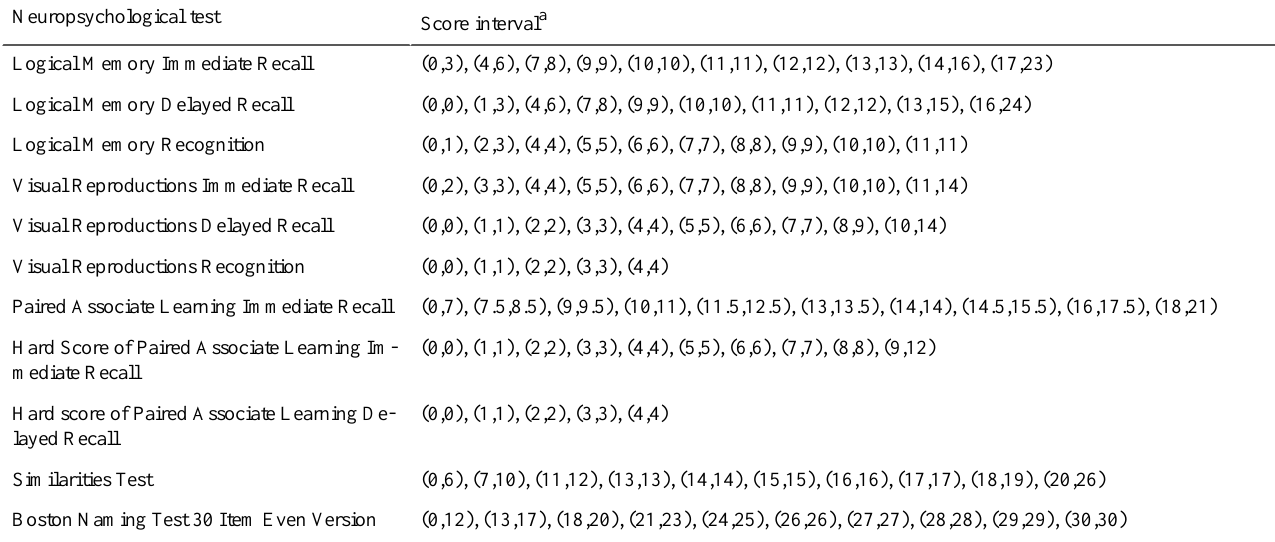
Table 3. Discretization of neuropsychological test